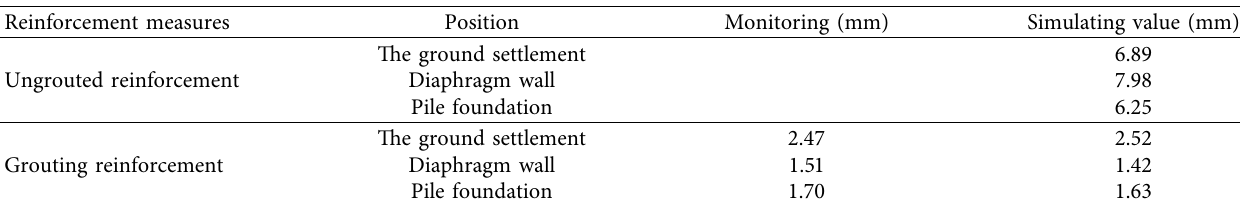
Table 3: Comparison of monitoring results and numerical